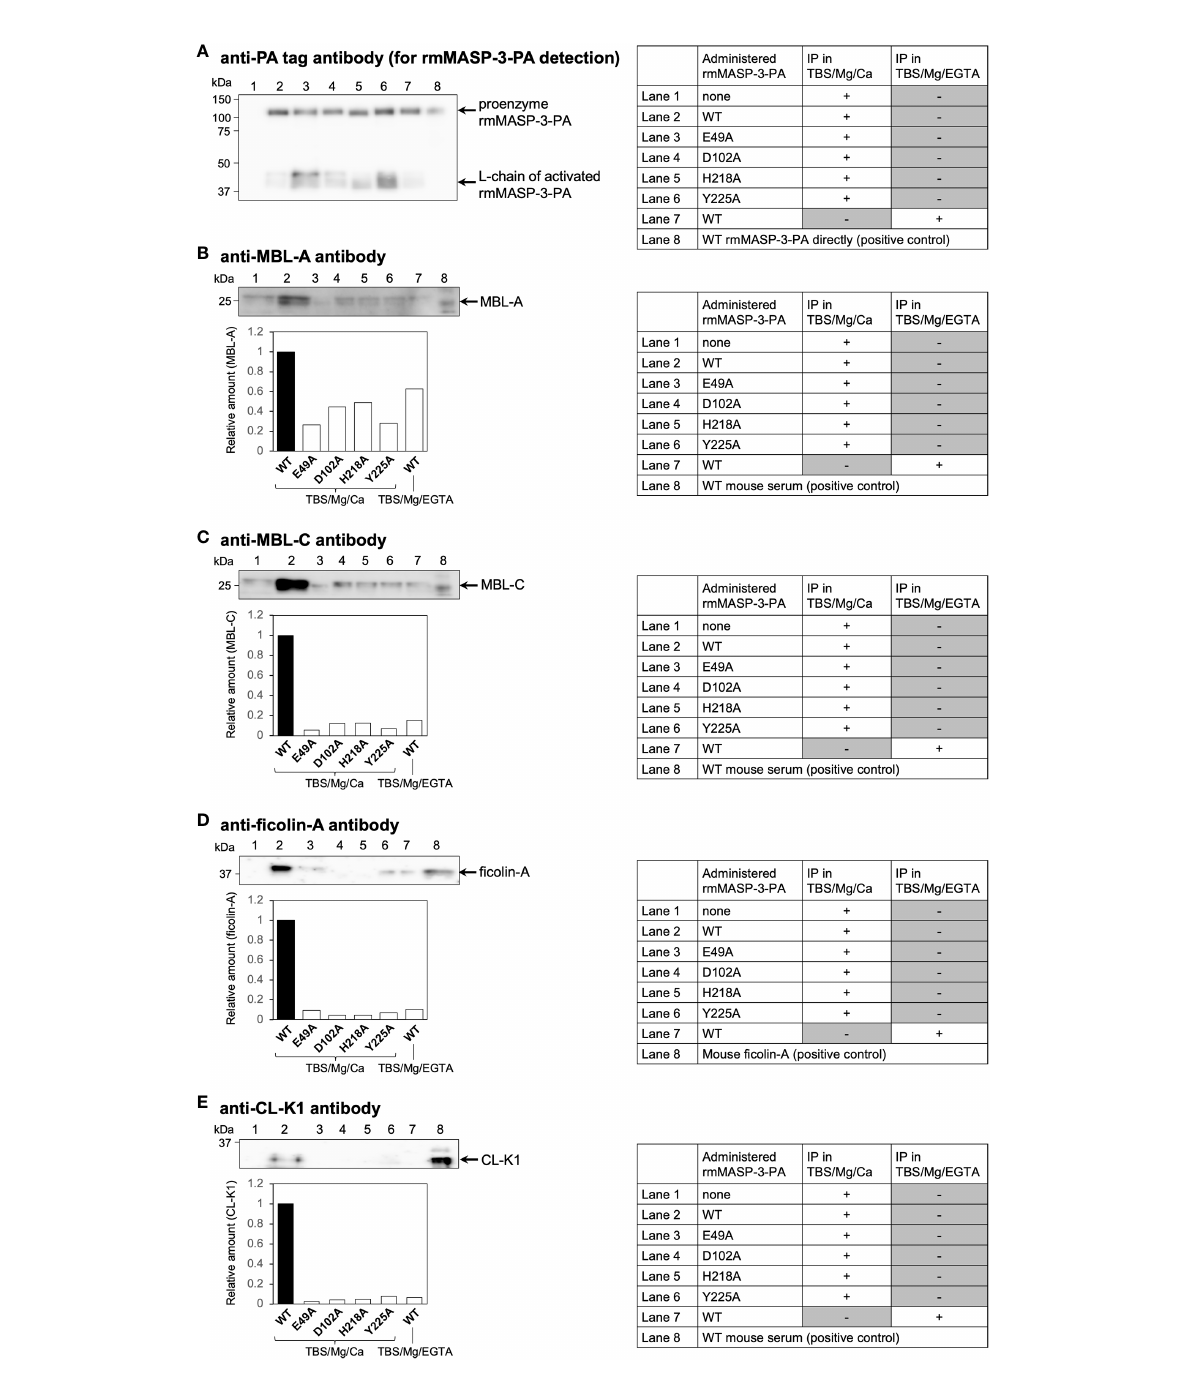
FIGURE 3 In-vivo complex formation of rmMASP-3-PA with endogenous MBL-A, MBL-C, fi colin-A or CL-K1. Immunoprecipitation (IP) experiments were performed using anti-PA tag antibody beads in TBS containing 7 mM MgCl 2 and 5 mM CaCl 2 (TBS/Mg/Ca) or 10 mM EGTA (TBS/Mg/EGTA). Each band intensity of MBL-A (B) , MBL-C (C) , fi colin-A (D) , and CL-K1 (E) was calibrated with the intensity of rmMASP-3-PA (A) obtained from the same IP sample to normalize the loading amount of rmMASP-3-PA between the samples. Relative amounts were expressed as the ratio of each calibrated intensity against that obtained from the mouse serum administered with WT rmMASP-3-PA (lower panels in B – E ; WT =